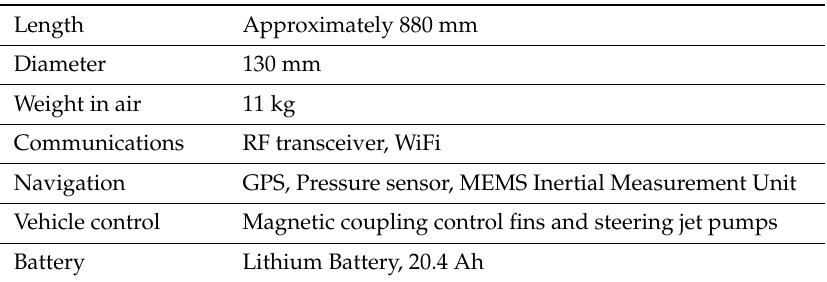
Table 2. Main vehicle specifications of the test bed AUV